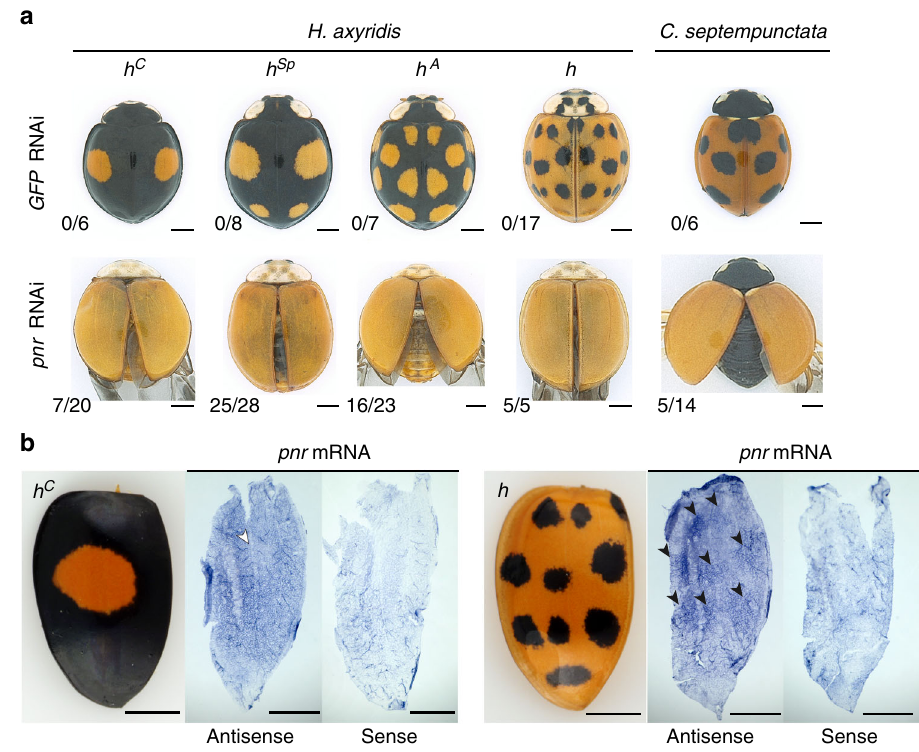
Fig. 3 pannier expression foreshadowing the adult colour pattern switches red/black pigmentation processes. a The adult phenotypes of RNAi treatments targeting GFP (negative controls, GFP RNAi) and pannier ( pnr RNAi) in H. axyridis ( h C , h Sp , h A , h ) and C. septempunctata . Scores in the lower left corners indicate penetrance of the loss-of-pattern phenotype in surviving animals. b The pattern of pannier expression ( pnr ) in the dorsal elytral epidermal cells immediately before or after pigmentation (76 − 84 h AP). Left panels indicate the corresponding adult elytral phenotypes ( h C and h ) adapted from Fig. 2a. White arrowhead, the region with a weak signal. Black arrowheads, the regions with intense signals. Scale bars, 1